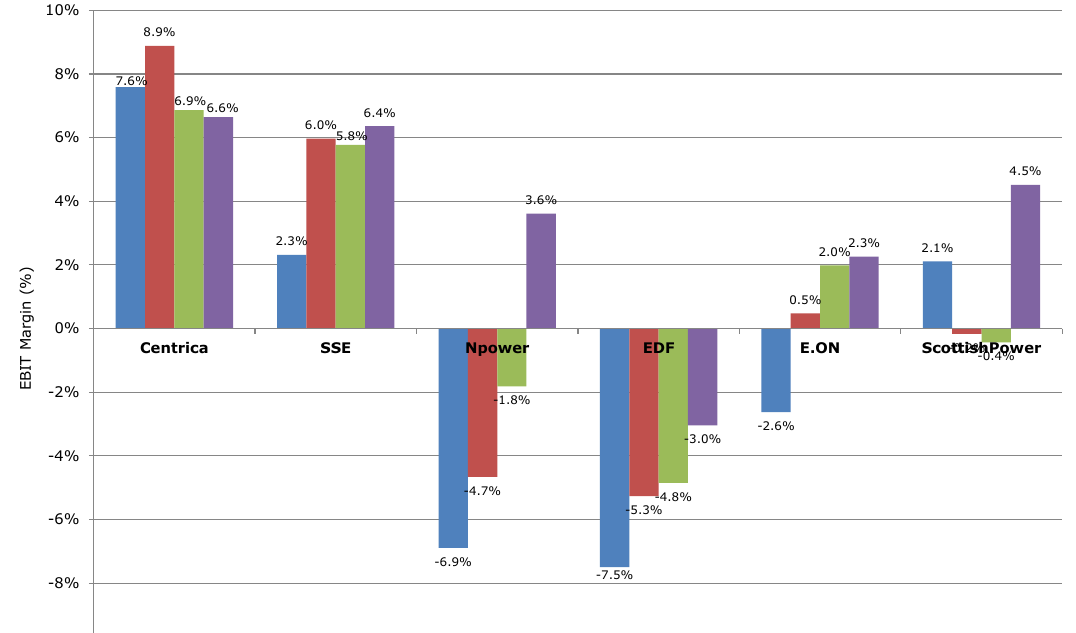
Figure 47: Six largest suppliers’ Domestic Electricity and Gas Supply EBIT Margins (% of